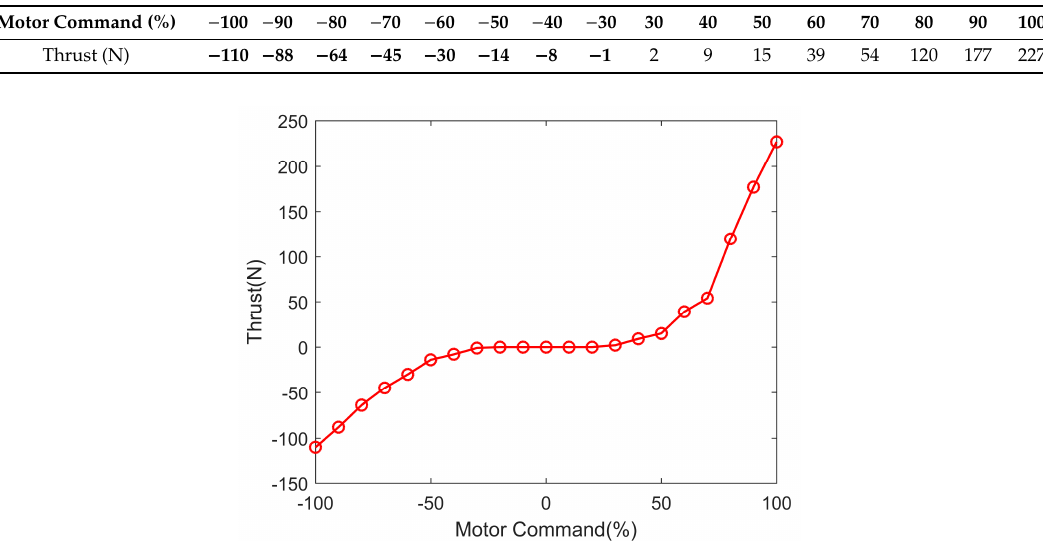
Figure 4. The relationship between motor commands and